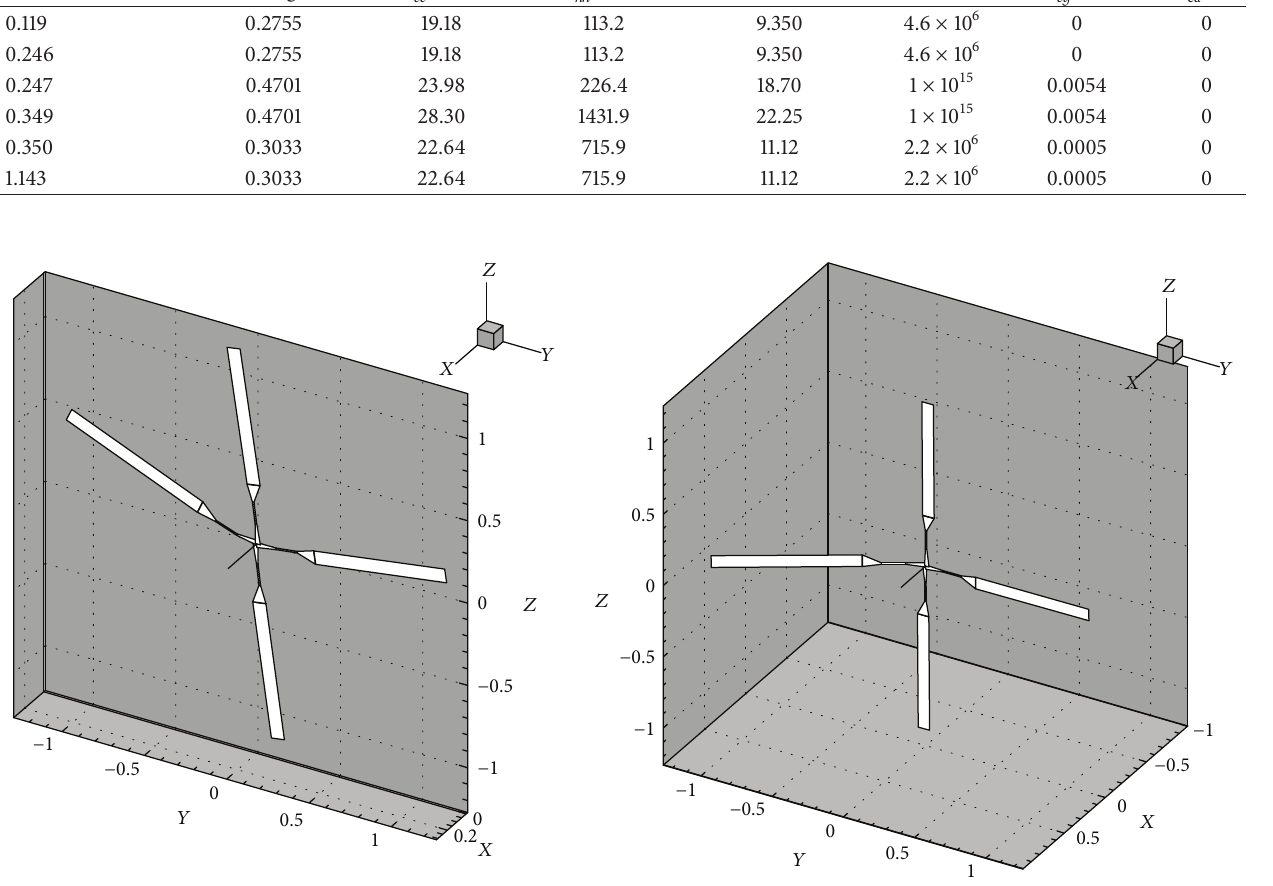
Figure 6: The modal shapes for the first flap and the first lag modes by the large deflection beam model.